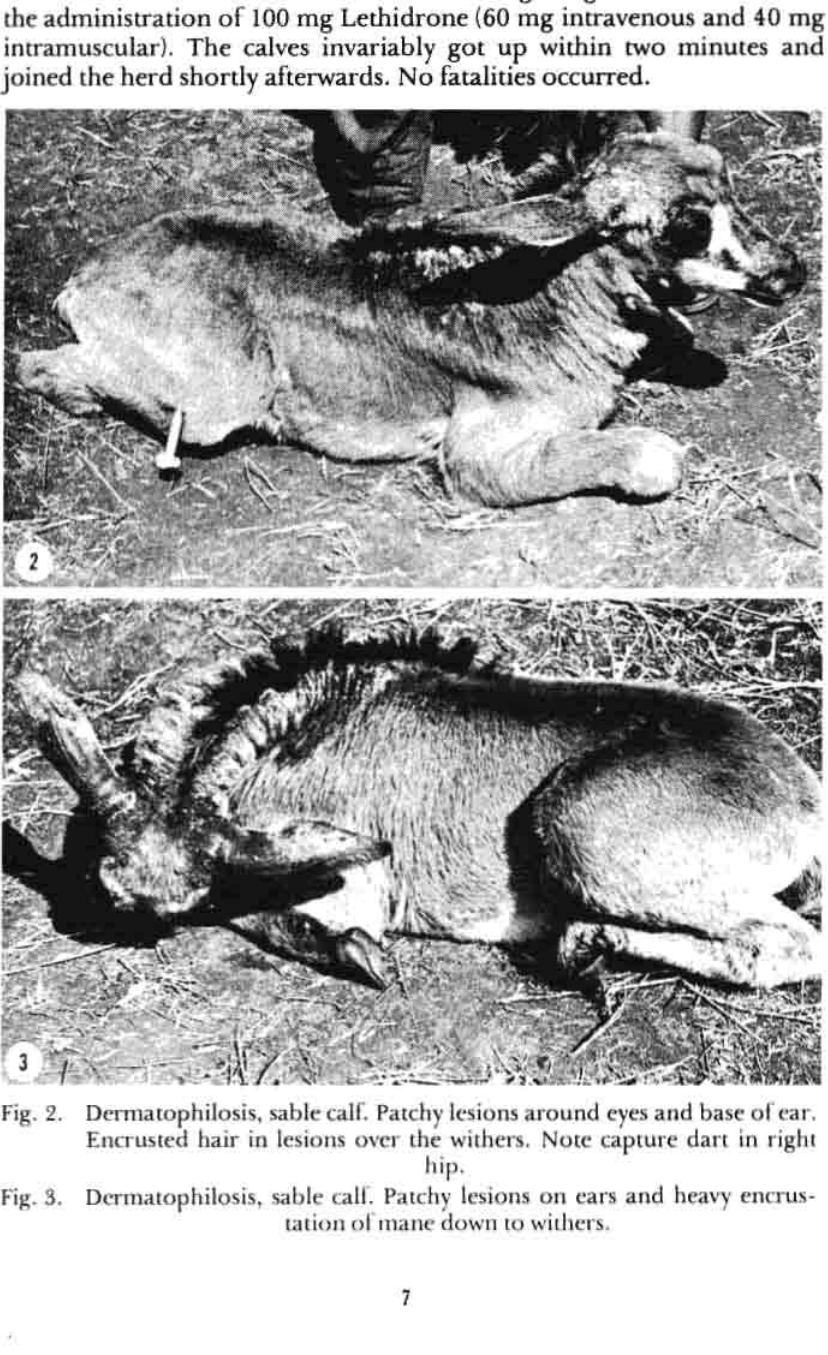
Derrnatophilosis. sable calf. Patchy lesions around eyes and base orcaI'. Encrusted hair in lesions over the withers. Note capture dart in right hip. Dermatophilosis, sable calf. Patchy lesions on cars and heavy encrus tatiun of mane down to withers.